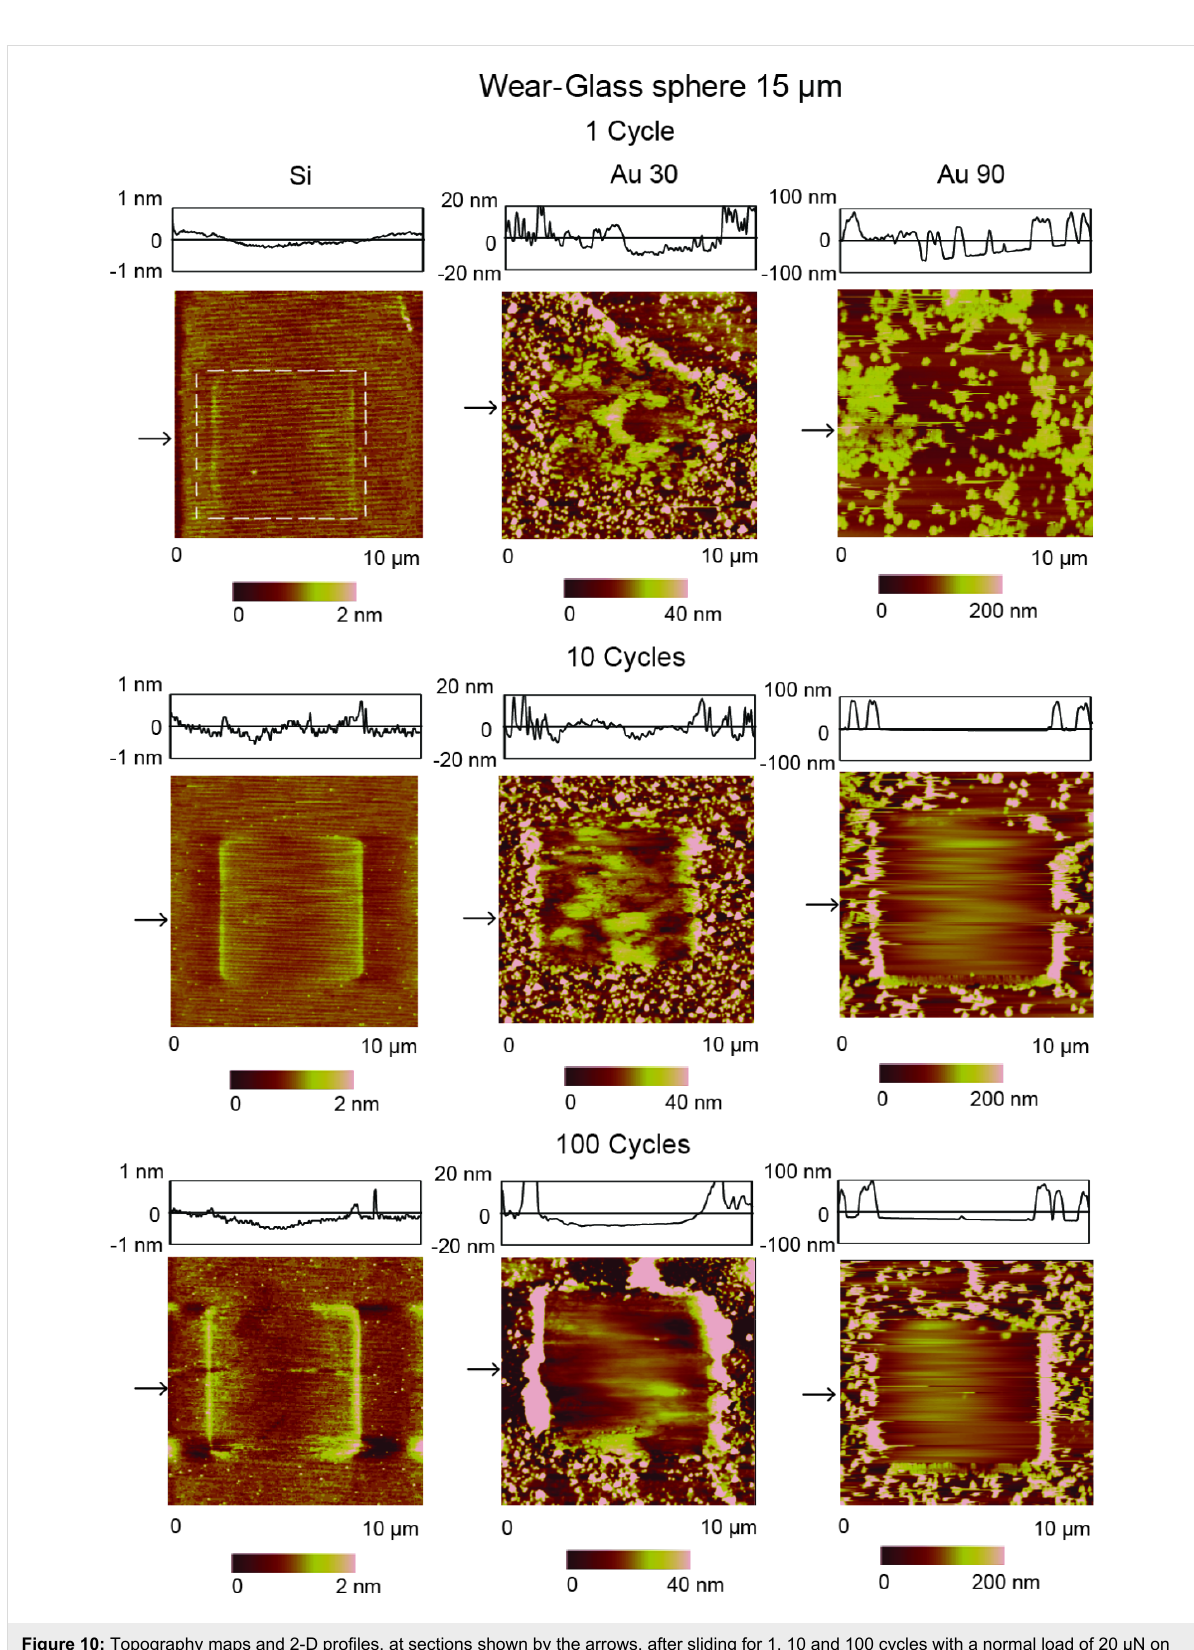
Figure 10: Topography maps and 2-D profiles, at sections shown by the arrows, after sliding for 1, 10 and 100 cycles with a normal load of 20 µN on Si and Si coated with Au 30 and Au